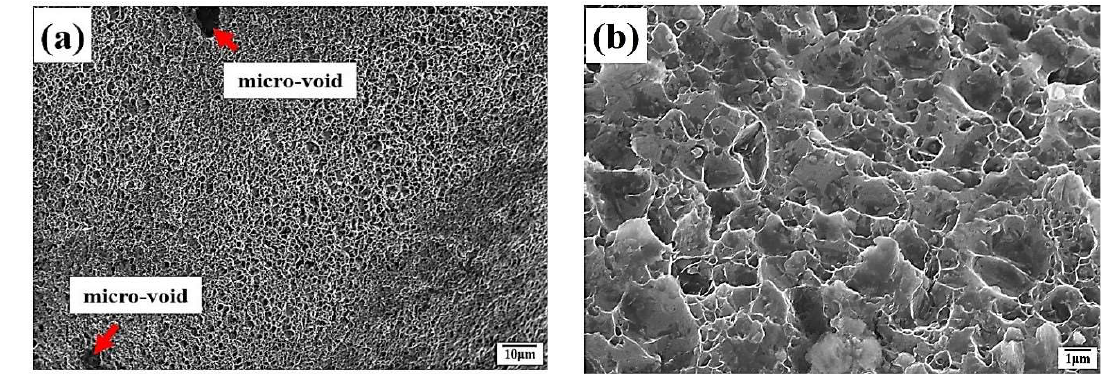
Figure 9. The morphology of fracture surface in the 1670-NA specimens: ( a ) low magnification; and ( b ) high magnification.